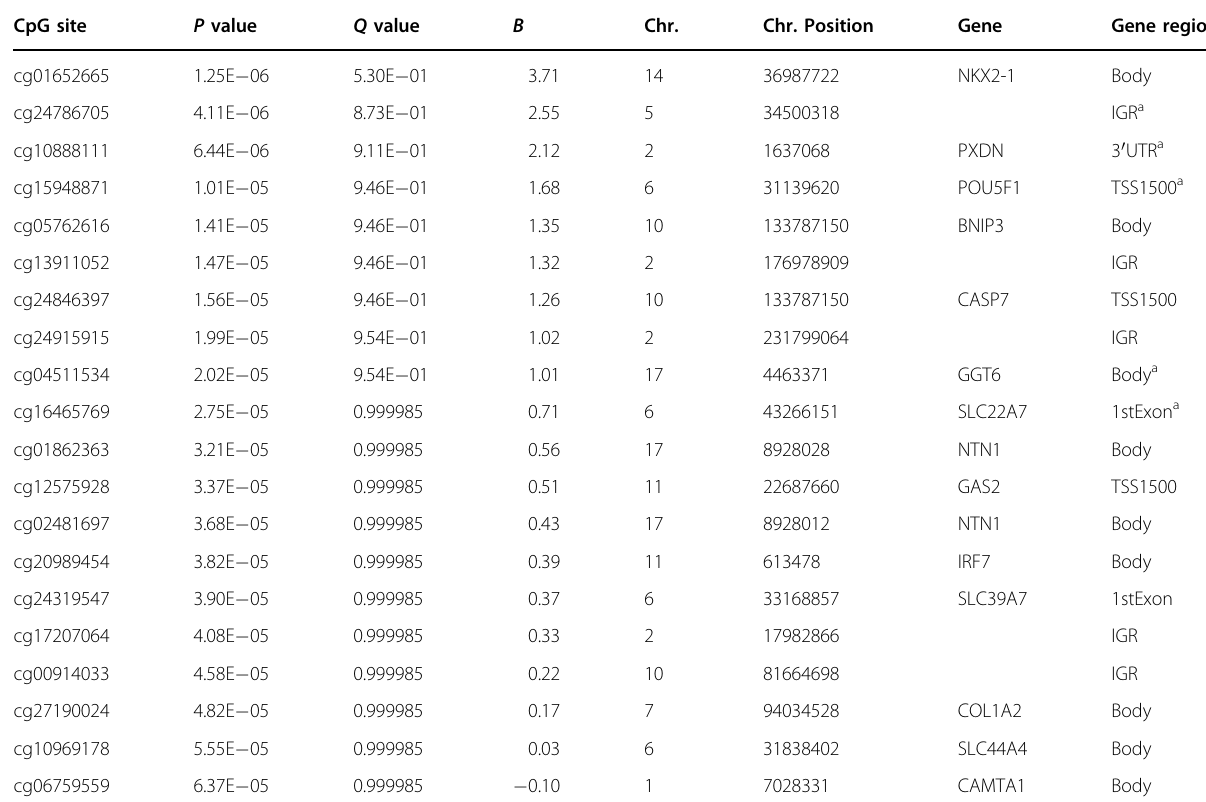
Table 3 Top 20 differentially methylated CpG sites resulting from the comparison between BPD + T patients ( N = 49) and BPD-T patients ( N =